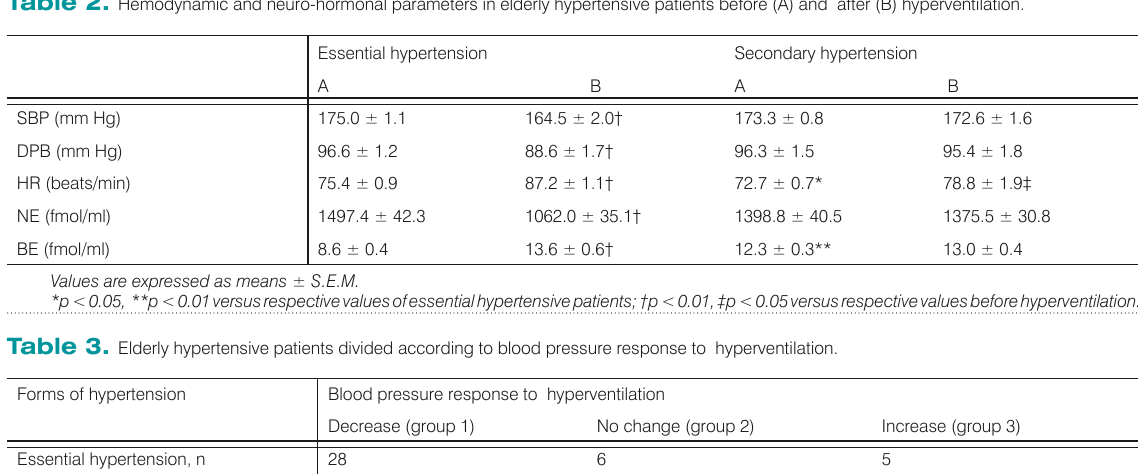
Table 2. Hemodynamic and neuro-hormonal parameters in elderly hypertensive patients before (A) and after (B) hyperventilation.